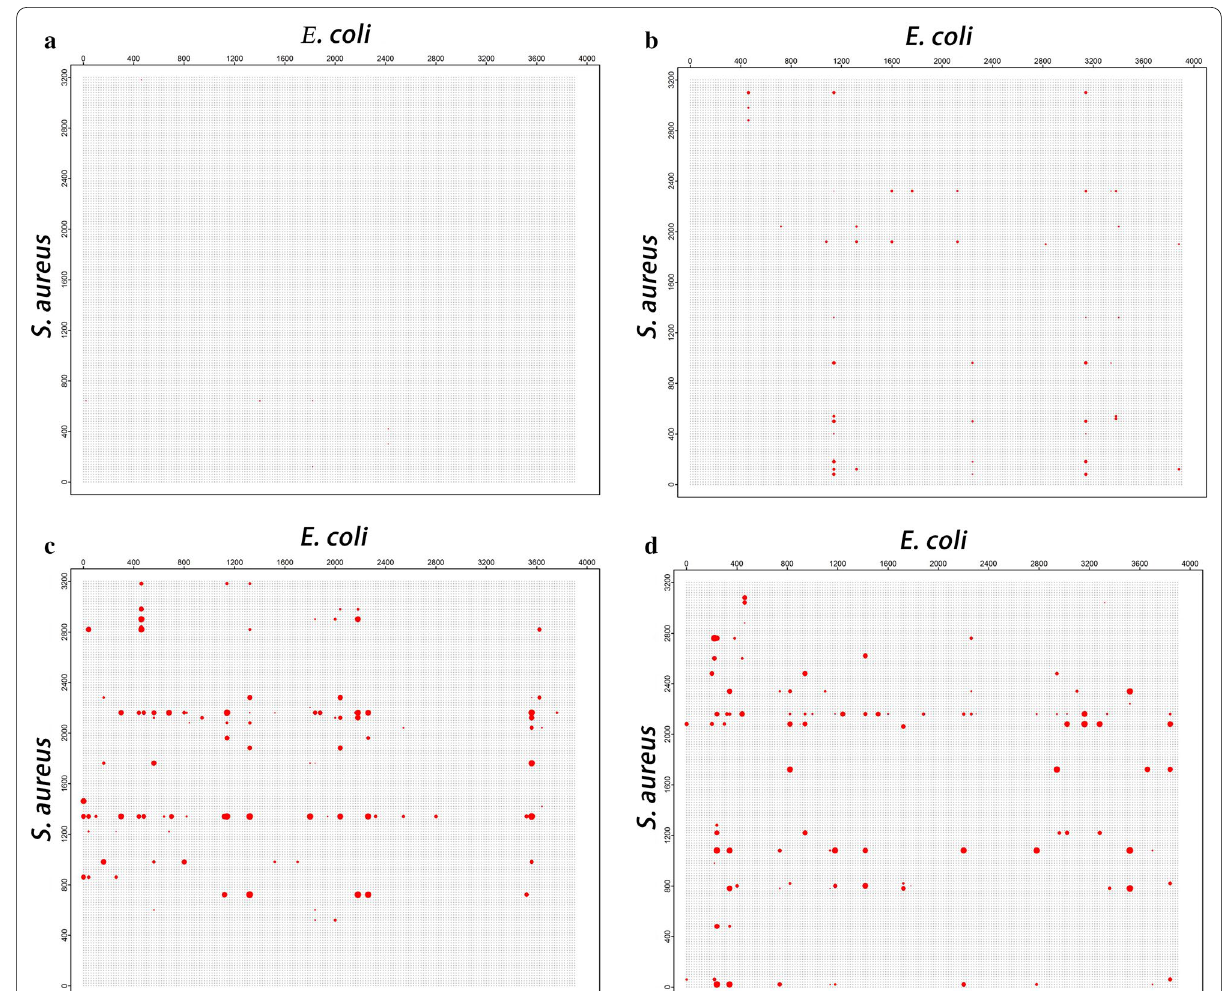
Fig. 4 Two-dimensional Manhattan plots based on growth parameters of E. coli and S. aureus in co-culture. a λ parameter; b R parameter; c A parameter; d s